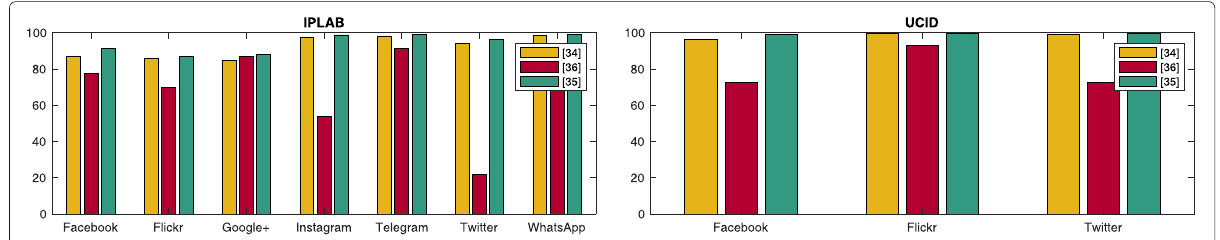
Fig. 4 Accuracy of different state-of-the-art approaches on the task of identifying the last sharing platform, as reported in the respective papers. The left barplot refers to the IPLAB dataset while the right one to the UCID Social dataset, and the analysis is performed on individual 64 × 64